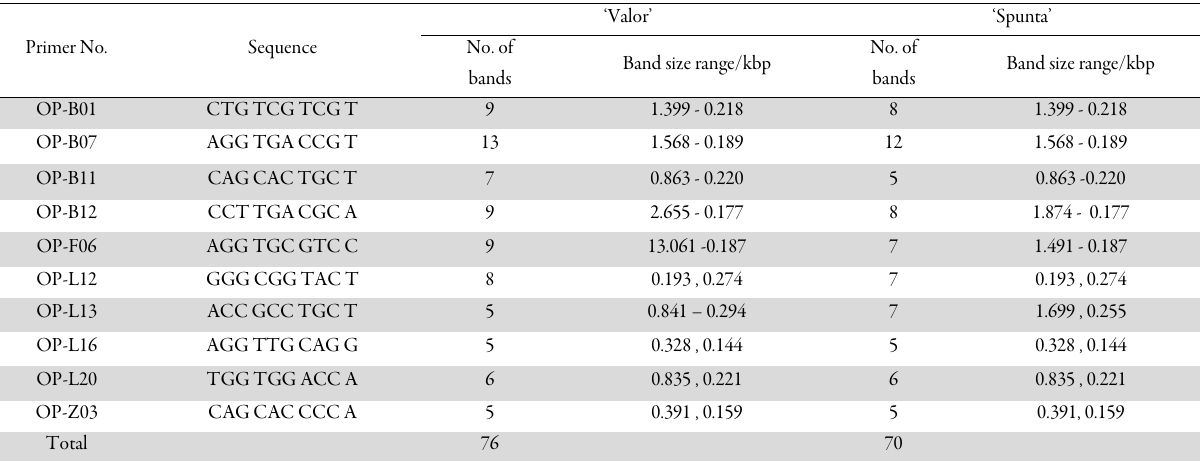
Table 2. Sequence of primers tested, the numbers of DNA fragments amplified and the size a kilobases (Kbp) in potato cvs. ‘Valor’ and ‘Spunta’ Primer No.